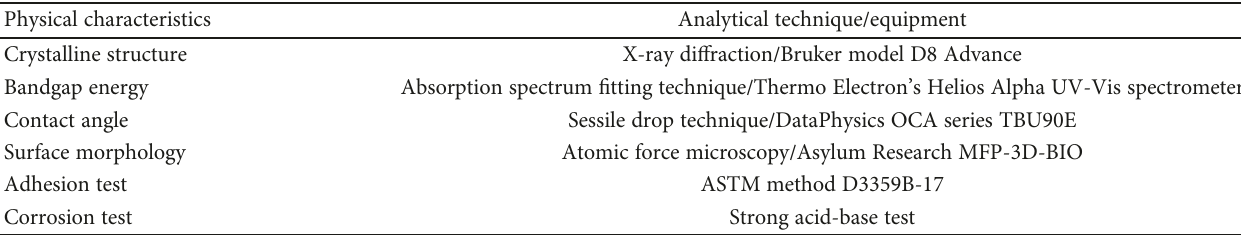
Figure 1: The schematic of the spray-coating chamber. Table 1: Physical characteristics and the corresponding analysis